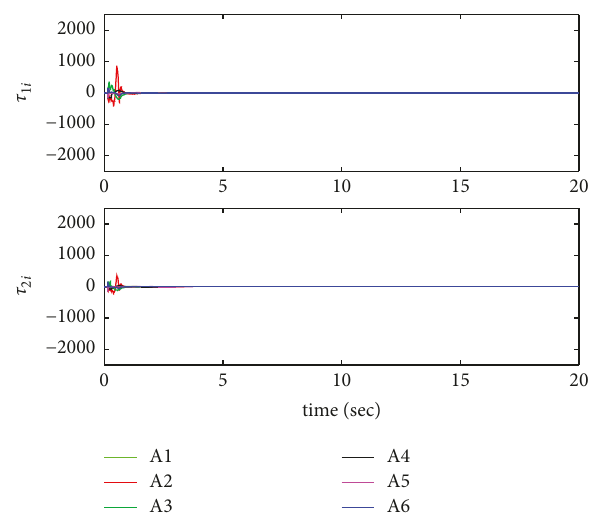
Figure 6: Simulation results of control inputs τ